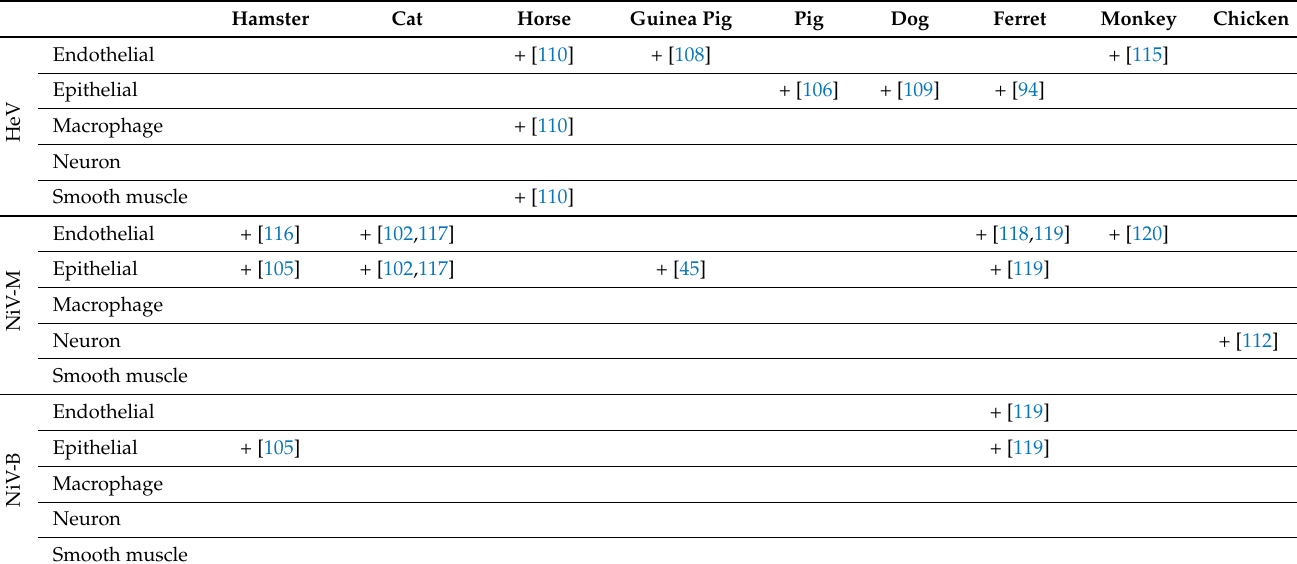
Table 2. Syncytium detection across cell types and hosts following experimental henipavirus infection in vivo. A “+” indicates that syncytia were reported at least once; blank spaces indicate that no data are available. Hamster Cat Horse Guinea Pig Pig Dog Ferret Monkey